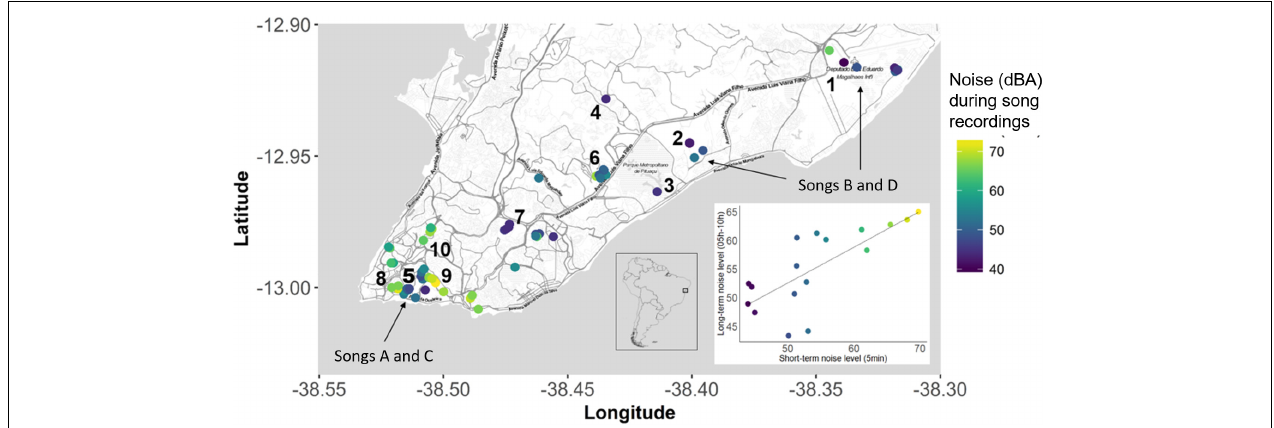
FIGURE 1 | Map representing the distribution of the recorded birds in the city of Salvador, Bahia, Brazil, and the variation of noise levels along sampled territories and in the correlational graph (long-term and short-term noise recordings). The color of the dots represents the intensity of the environmental noise (in decibels, A-curve), measured during the recording of bananaquit songs. In a continuous colored scale, purple dots represent quieter territories and yellow dots the noisier territories. Indicated by numbers are example of quieter and noisier localities and their respective habitat types: Tropical sand dunes of (1) “Parque da Dunas,” Atlantic forest fragments of (2) “Vale Encantado,” (3) “Parque de Pituaçu,” (4) “Jardim Botânico,” (5) “Parque Zoobotânico Getúlio Vargas”, and (6) “Coelba,” Urban Gardens of (7) “Jardim da Saudade,” and (8) Federal University of Bahia; Main avenues in (6) “Coelba,” (9) “Garibaldi,” and (10) “Dique.” Map made with ggmap package (Kahle and Wickham,